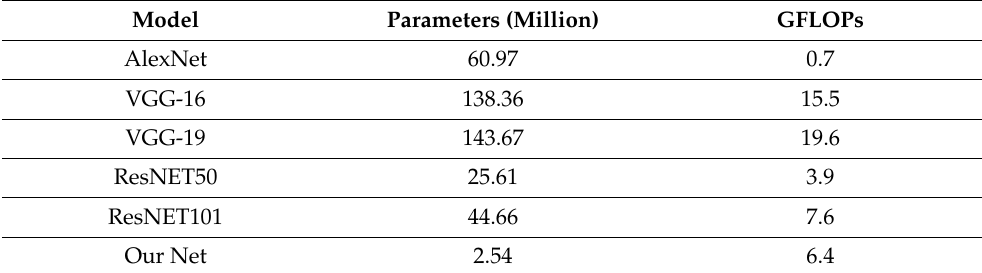
Table 1. Parameters and GFLOPs for common models and our network.